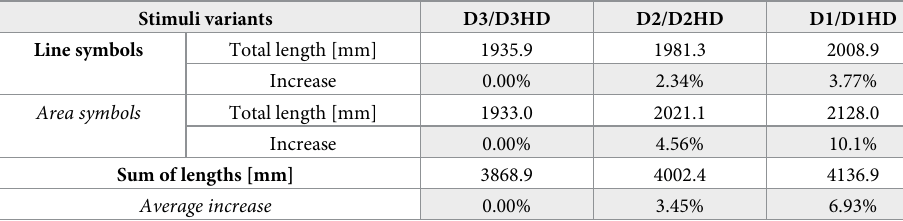
Table 10. Geometric measures of line and area symbols on tactile stimuli.